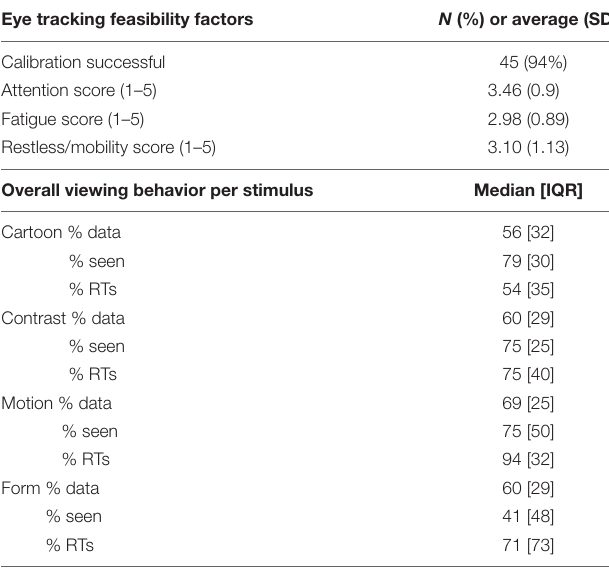
TABLE 3 | General VOF results in the total group of preterm children at 1 year CA.